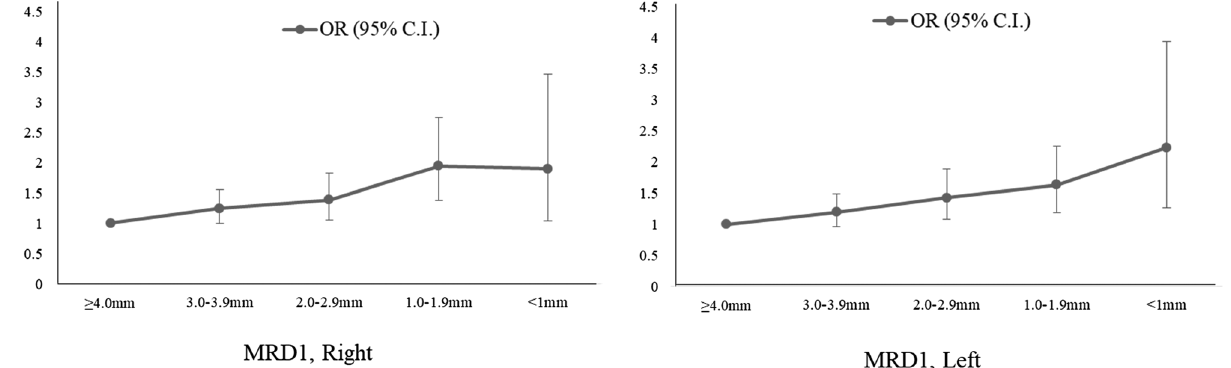
Figure 2. OR with 95% CI for cataract incidence according to MRD1 level in both eyes. As the level of MRD1 decreased, there is a tendency to increase odds ratio of cataract in the right eye and the left eyes and it is statistically significant (p = 0.0038, right eye, p = 0.0118, left eye, respectively).